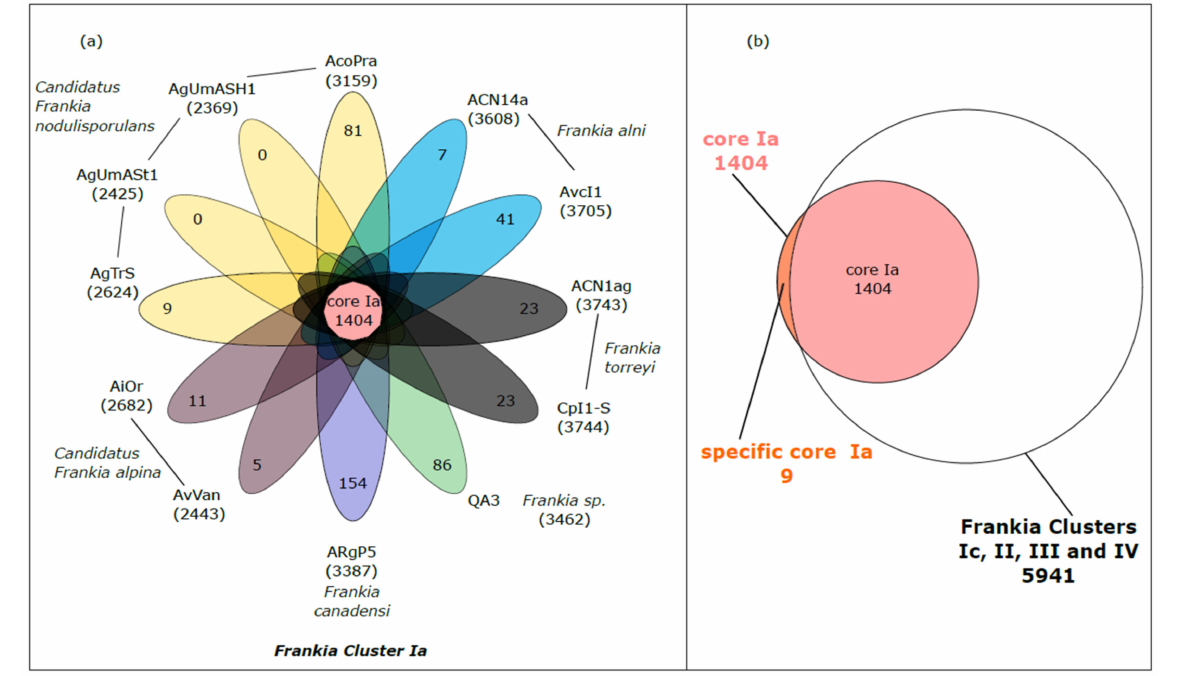
Figure 1. Multigenomic analysis permitted to identify the core genome of Frankia belonging to the Cluster Ia and the specific core Ia. ( a ) Flower plot diagram of strains from Cluster Ia. The number within brackets associated to each strain indicates the number of genes in the genome (number of unique CDS). The central circle shows the number of genes common to all strains while the petals show the number of genes specific to each strain. The strains belonging to the same species are shaded with the same color. ( b ) Venn diagram showing the specific core Ia (genes both present in the core-genome of Frankia belonging to the Cluster Ia and absent in the pan genome of the Frankia belonging to the Clusters Ic, II, III and IV). Table 3. Genes both present in the core genome of Frankia belonging to the Cluster Ia and absent in the pan genome of the Frankia belonging to the Clusters Ic, II, III and IV (specific core Ia). Label, Begin, End and Length are given for Frankia ACN14a as a reference genome. “SP” and “TM” for Secreted Proteins and Transmembrane Proteins,